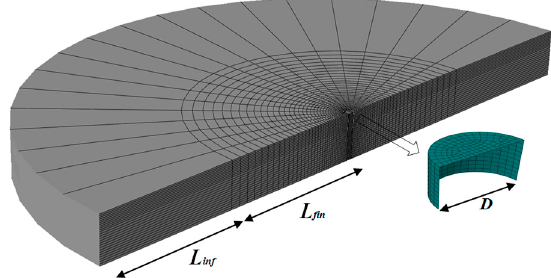
Figure 5. Coupling model combined finite element with an infinite element domain.